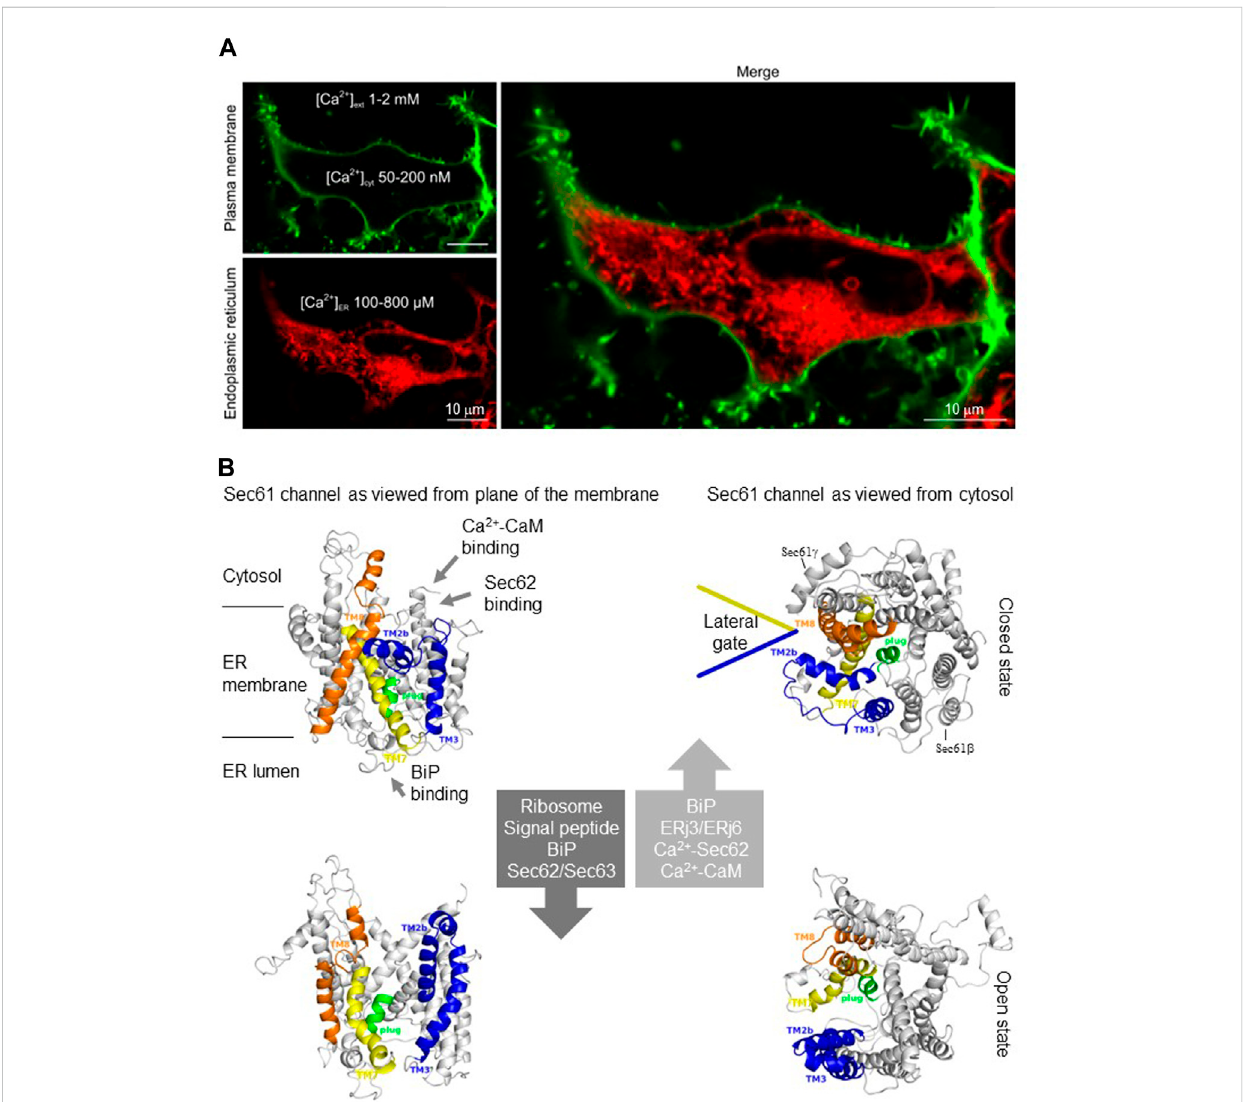
FIGURE 1 I The endoplasmic reticulum (ER) of nucleated human cells has major functions in cellular calcium homeostasis and contains the abundant and ubiquitous Sec61 channel. (A) The ER is shown here in a HEK293 cell after fl uorescence microscopy after staining with ER-Tracker ™ Red (BODIPY ™ TR Glibenclamide), the plasma membrane was stained with CellMask ™ Green Plasma Membrane Stain (details are given by Pick et al.). The image was kindly provided by Tillman Pick (Experimental and Clinical Pharmacology and Toxicology, Saarland University). (B) The Sec61 channel is shown in its modeled closed (top) and open (bottom) conformational states, as indicated (adopted from Lang et al., 2017). These two states are proposed to be in a dynamic equilibriumwitheachother.ThefullyopenstateoftheSec61channelallowstheinitialentry ofprecursorpolypeptidesfromthecytosolintothe ER lumen and ER membrane, respectively. In addition, it allows the passive ef fl ux of Ca 2+ from the ER lumen into the cytosol after termination of the translocationprocessand,therefore,itcanbequanti fi edinlivecellCa 2+ imagingincytosolandERlumenusingratiometricdyesand fl uorescentproteins. Ca 2+ ef fl ux may also be possible in the transition state (not shown), which can be detected in the presence of Sec61 channel inhibitors such as EeyarestatinsorMycolactoneandmaybeidenticaltotheso-calledprimedstatethatcanbeinducedbyribosomesinco-translational-andbytheSec62/ Sec63 complex in post-translational-transport (Gamayun et al., 2019; Bhadra et al.,